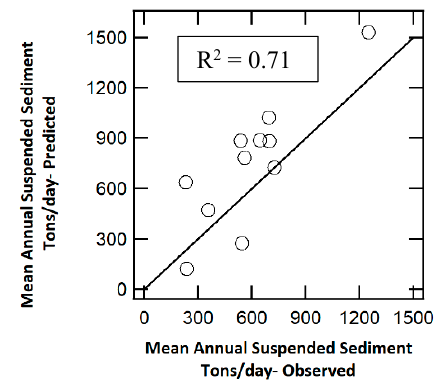
Figure 9. Observed and predicted suspended sediment yield.